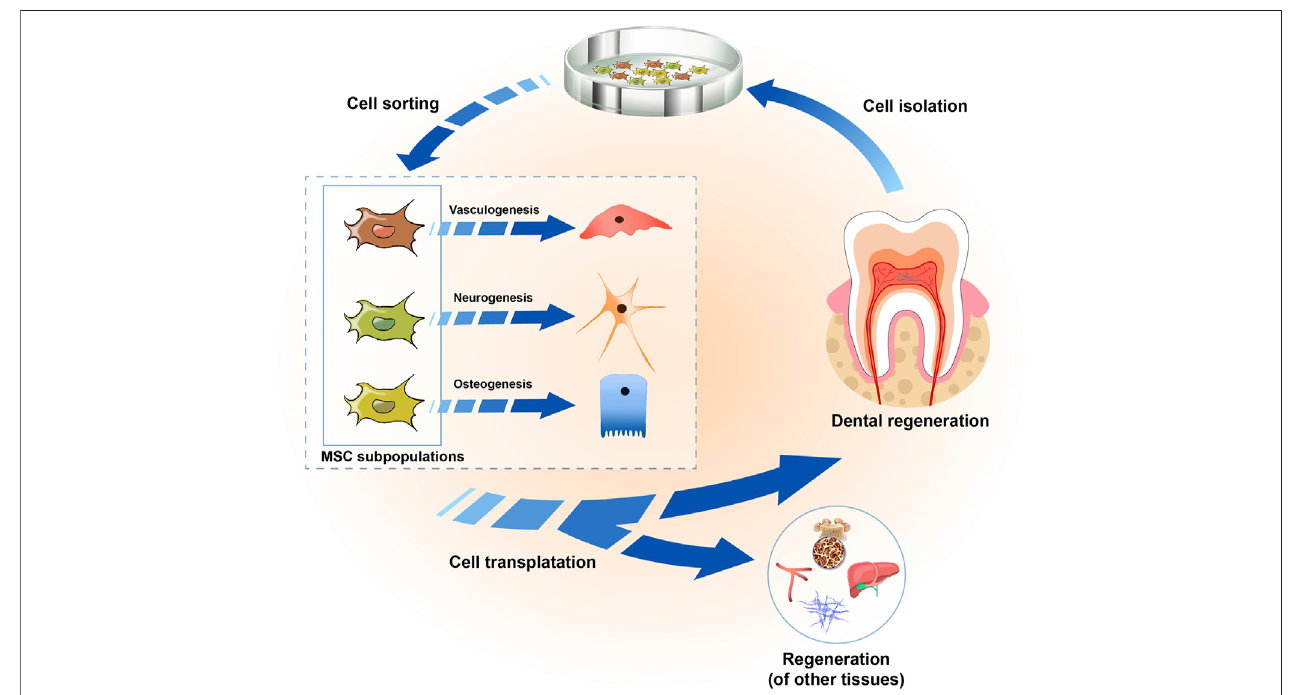
FIGURE1| StrategiesforutilizingtheodontogenicMSCheterogeneityintissueregeneration.OdontogenicMSCswereisolatedfromdentaltissue,includingdental pulp, periodontal ligaments, dental follicles, apical papillae, and the gingiva, and they showed heterogeneity in terms of their pluripotency in vitro culture. They could be sorted into several cell subpopulations according to their characteristics, with enhanced vasculogenic, neurogenic and osteogenic differentiation abilities. In the regeneration of teeth or other tissues, such as bone, liver, nerves and blood vessels, the selection of one or more cell subpopulations according to different needs might improve the outcomes of regenerative